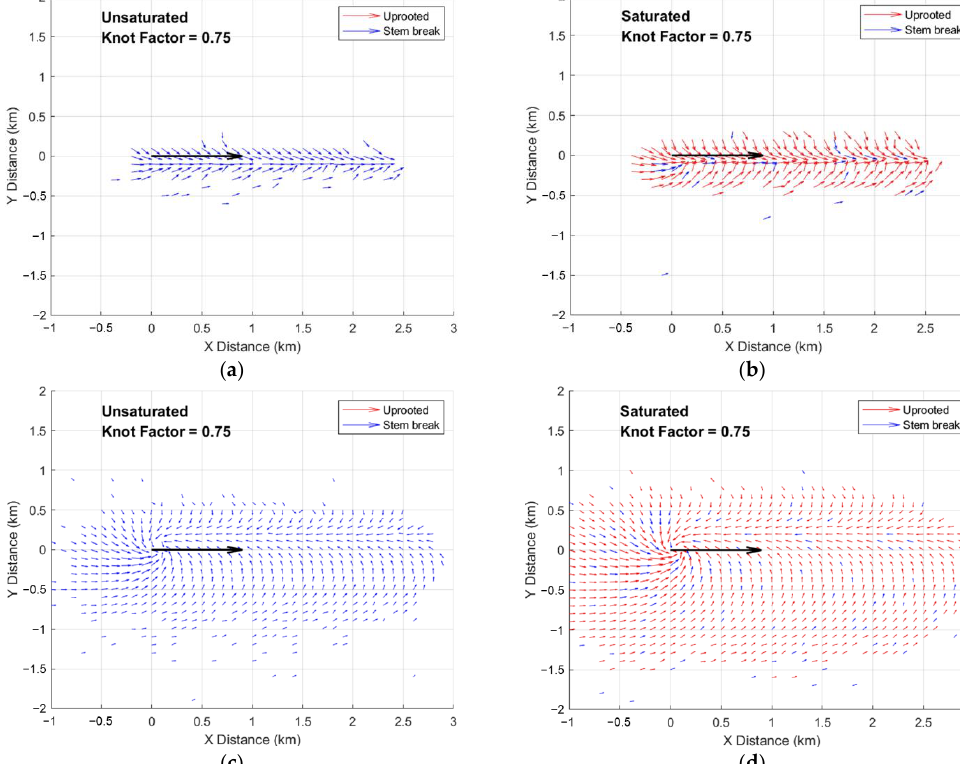
Figure 11. Treefall patterns of trees with random H·DBH 2 and knot factor = 0.75: vortex translating with V max = 52 m/s, G max = 3 on a ( a ) unsaturated soil and ( b ) saturated soil, vortex translating with V max = 91 m/s, G max = 6 on a ( c ) unsaturated soil and ( d ) saturated soil. Other vortex parameters are kept constant as R max = 240 m, φ = 0.7, α = 30°.